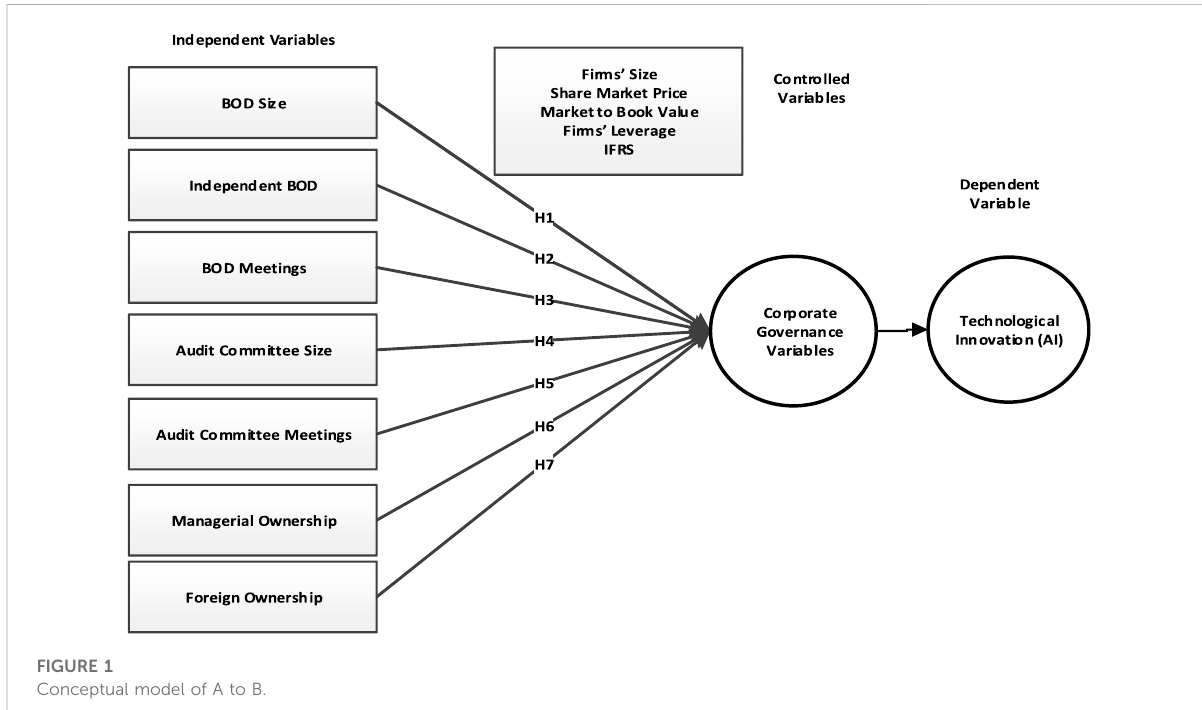
FIGURE 1 Conceptual model of A to